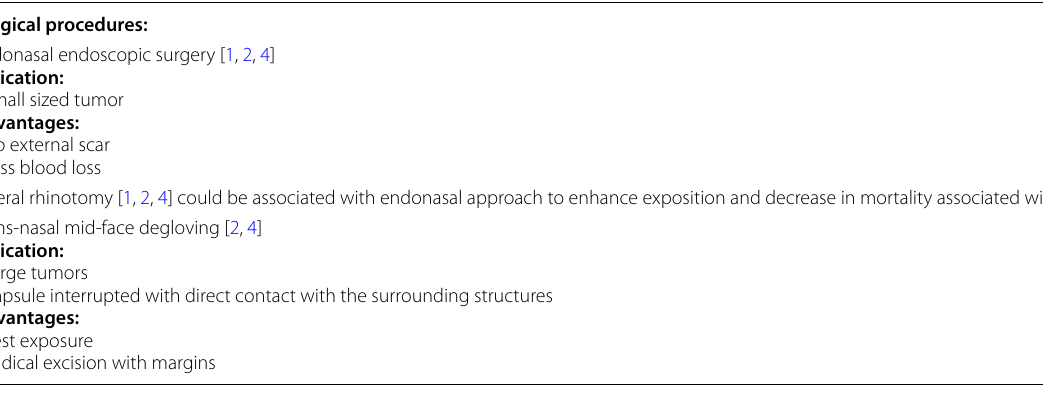
Table 2 Surgical procedures possibilities in pleomorphic adenoma in nasal cavities Surgical